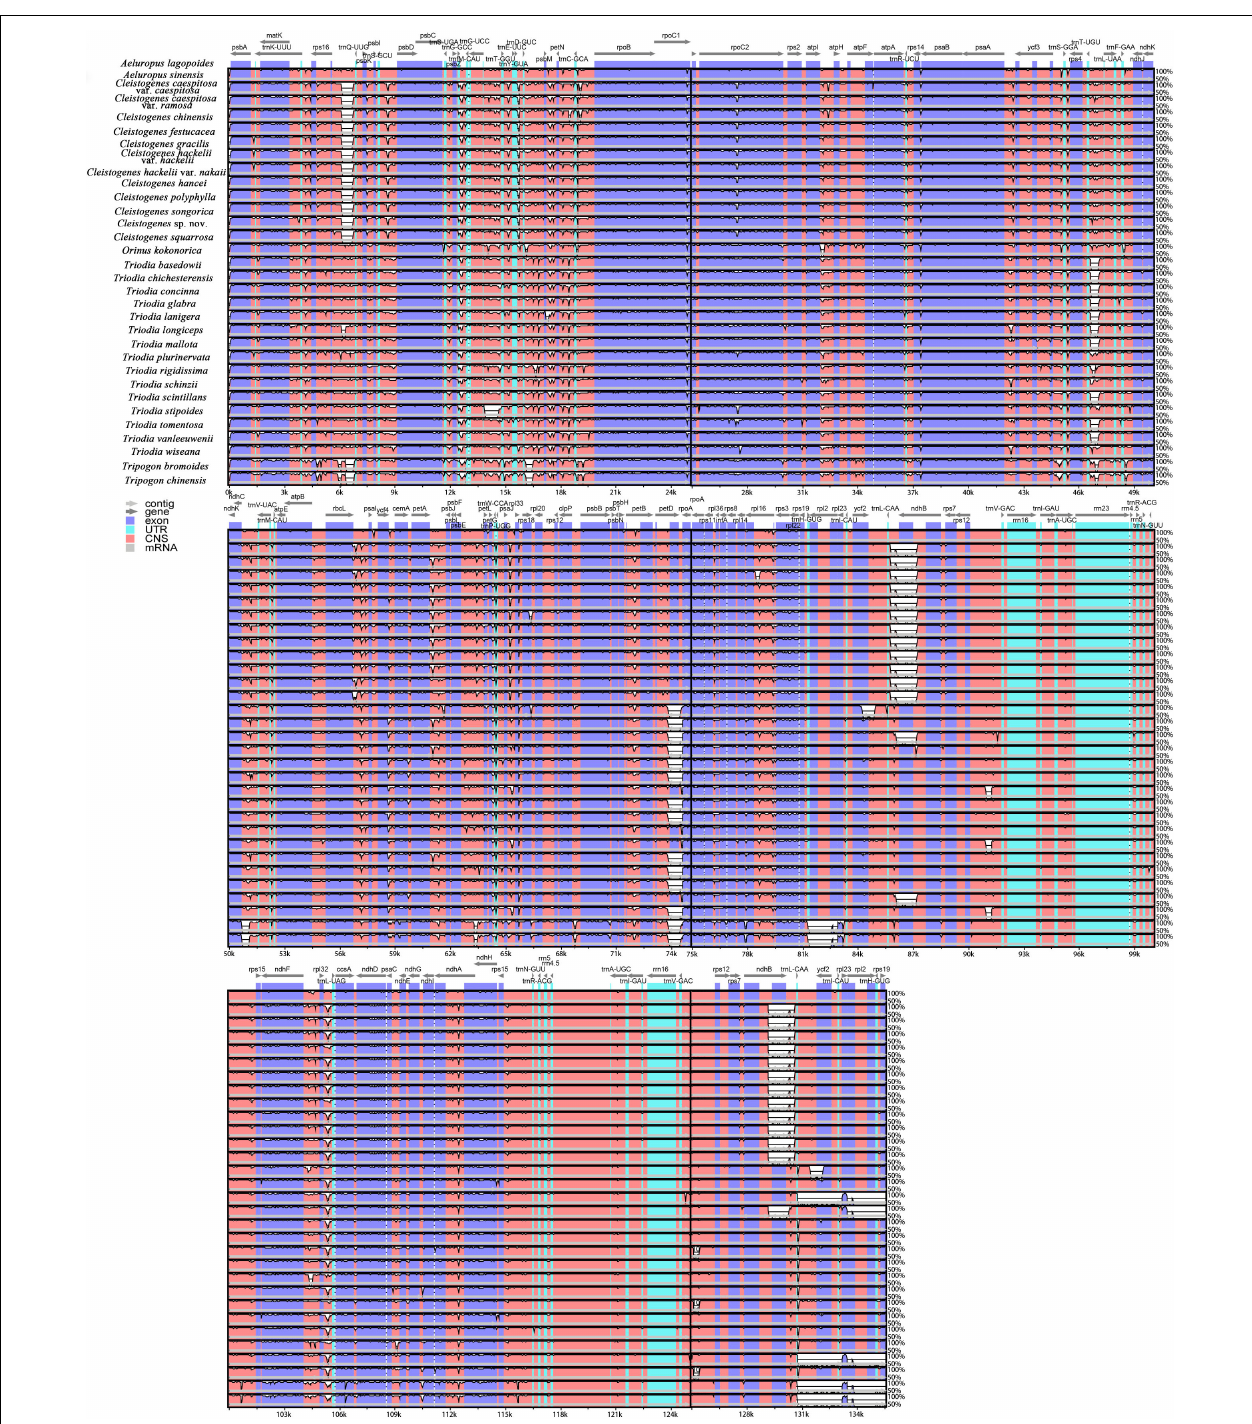
FIGURE 5 | Comparative analysis of the plastomes of 32 taxa. The plastome of Aeluropus lagopoides was used as a reference. The vertical scale indicates the percentage of identity, ranging from 50 to 100%. Genome regions are color-coded as exon, UTR, and conserved non-coding sequences (CNS).